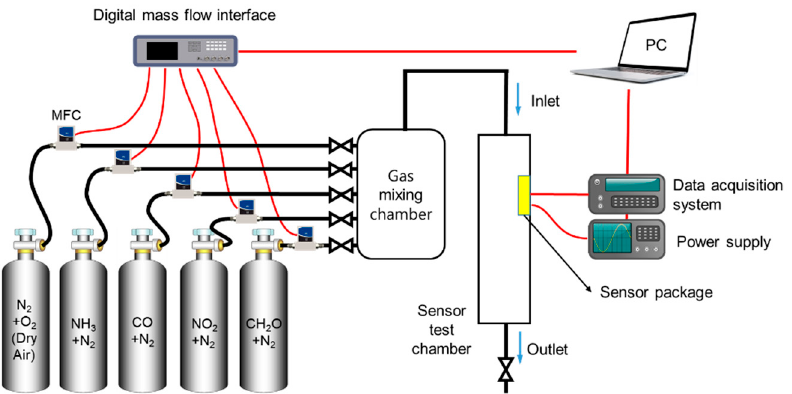
Figure 3. Schematic diagram of computer ‐ controlled continuous gas flow system for sensor characterization.